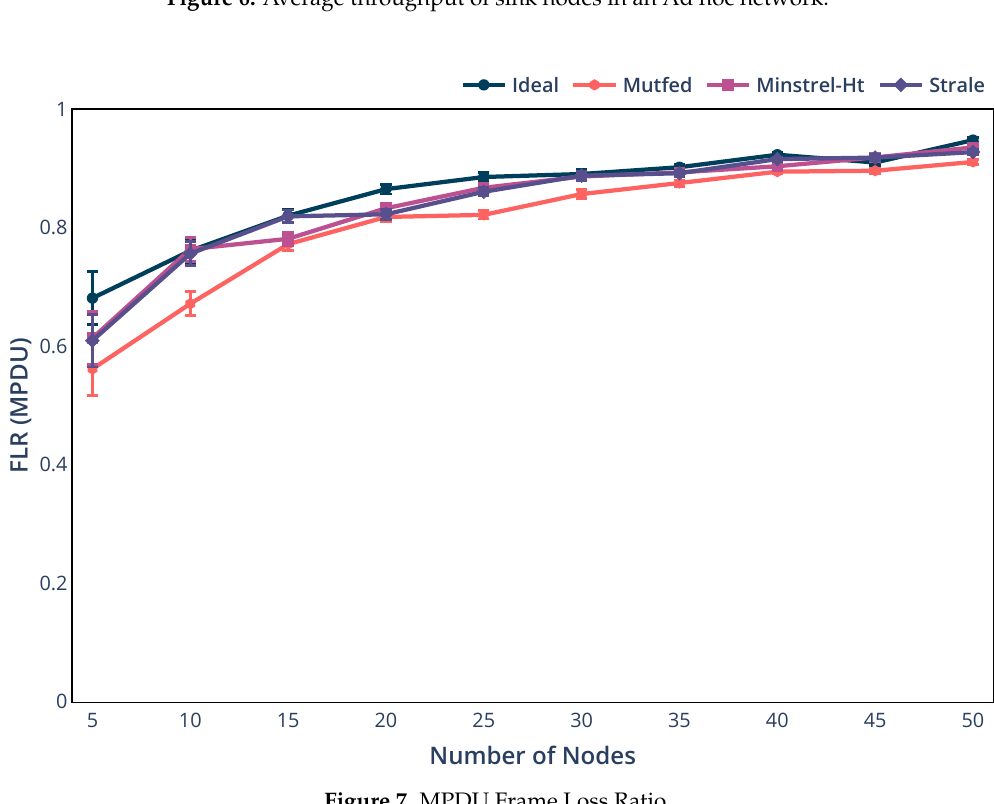
Figure 6. Average throughput of sink nodes in an Ad hoc network.